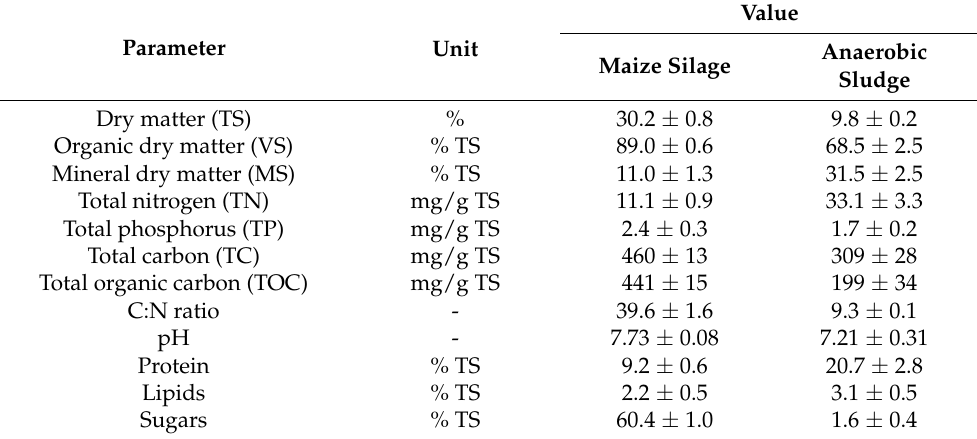
Table 1. Profile of the maize silage and anaerobic sludge.